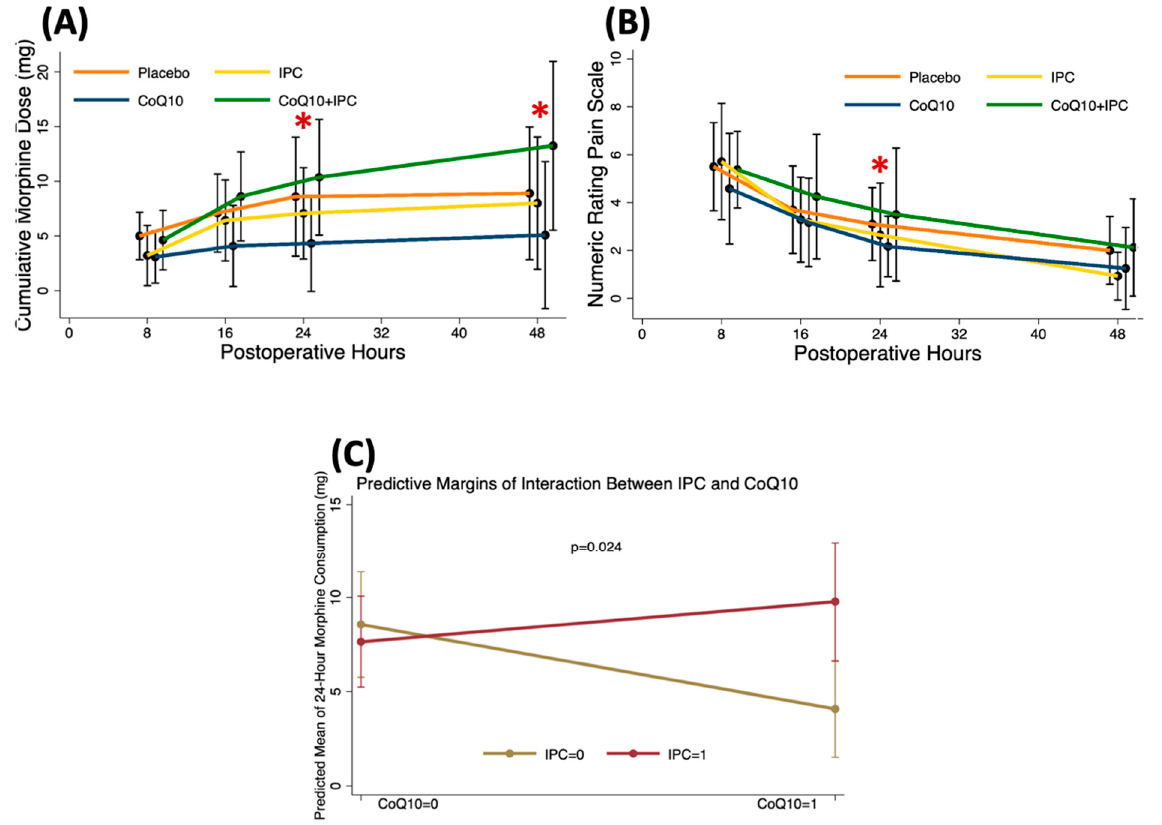
Figure 5. Postoperative pain during the first 48 h in TKA patients receiving placebo vs. IPC vs. CoQ10 vs. CoQ10 + IPC. ( A ) morphine consumption, ( B ) pain score, ( C ) predicted mean of 24 h morphine consumption. * p < 0.05 among the four groups.